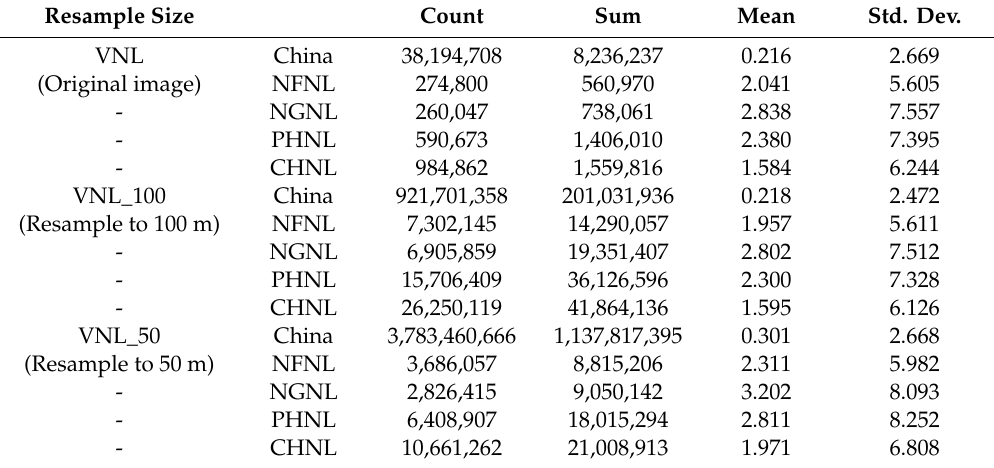
Table 2. The statistics information of resample results at di ff erent spatial